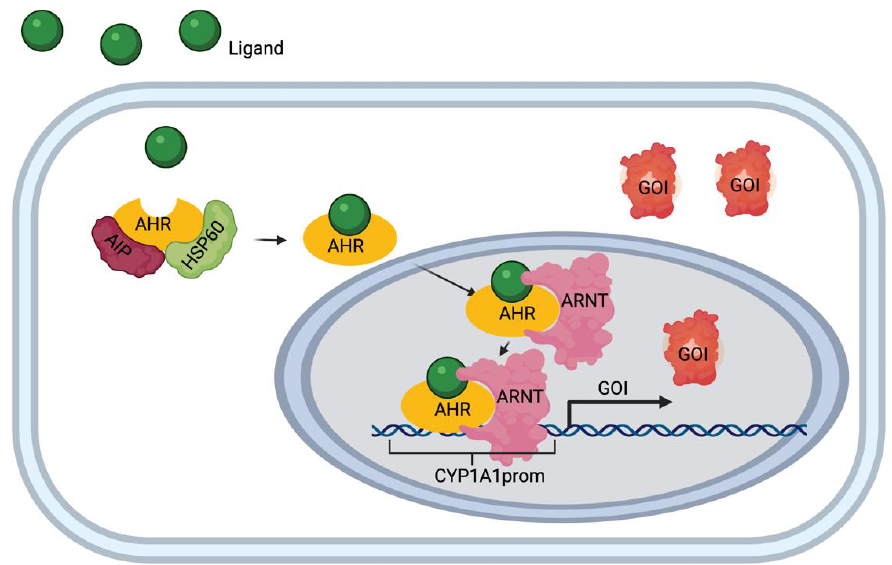
Figure 1. Aryl hydrocarbon receptor (AHR)/Cytochrome P450, family 1, subfamily A, polypeptide 1 (CYP1A1) pathway diagram. Ligand (e.g. apigenin) enters the cell and binds to the receptor complex (AHR, interacting protein (AIP) and heat shock protein 60 (hsp 60). The AHR-ligand complex translocates to the nucleus upon binding to AHR response elements (AHRE). Once in the nucleus, the complex binds to the CYP1A1 promotor (CYP1A1prom) and initiates the transcription and translation of the gene of interest (GOI).